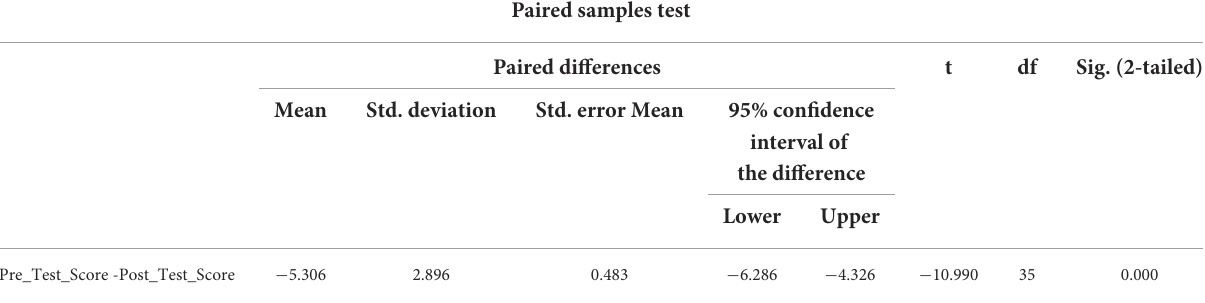
TABLE 3 Overall participant’s feedback.